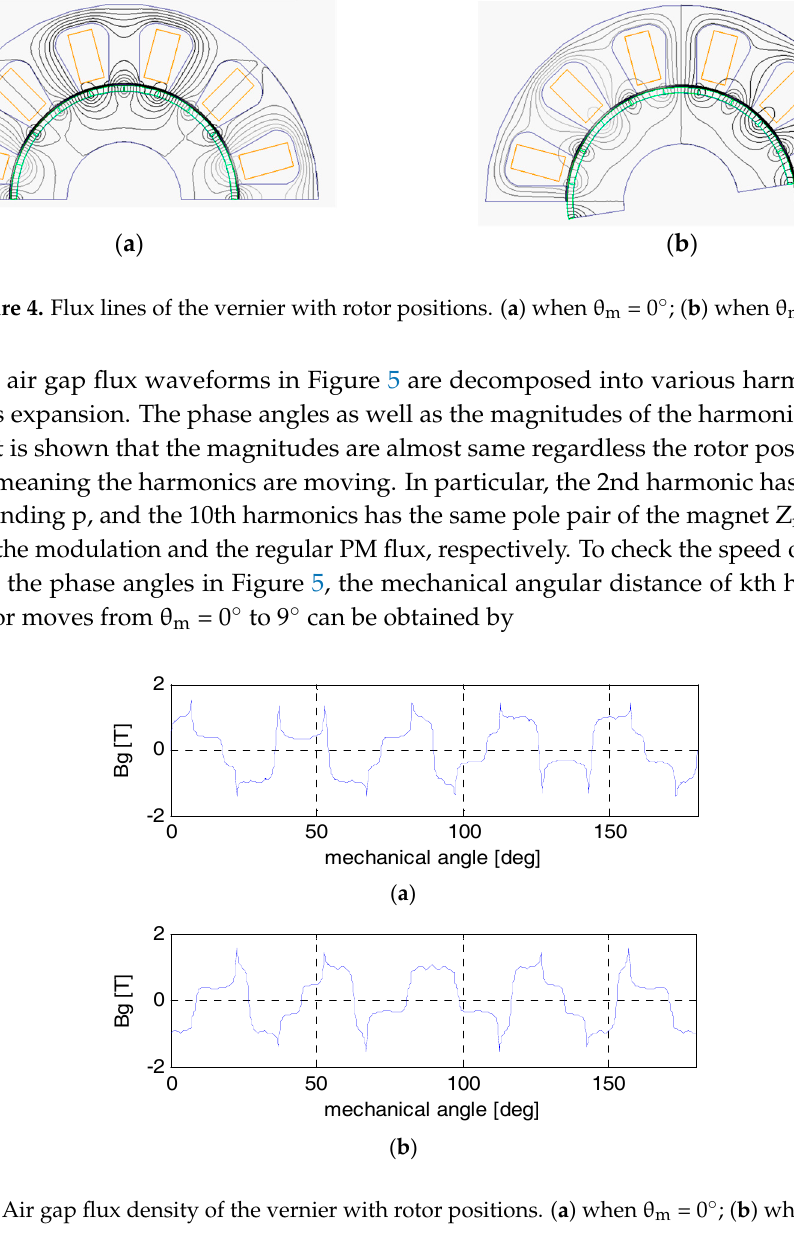
◦ ; ( b ) when θ ◦ m = 0 m = 9